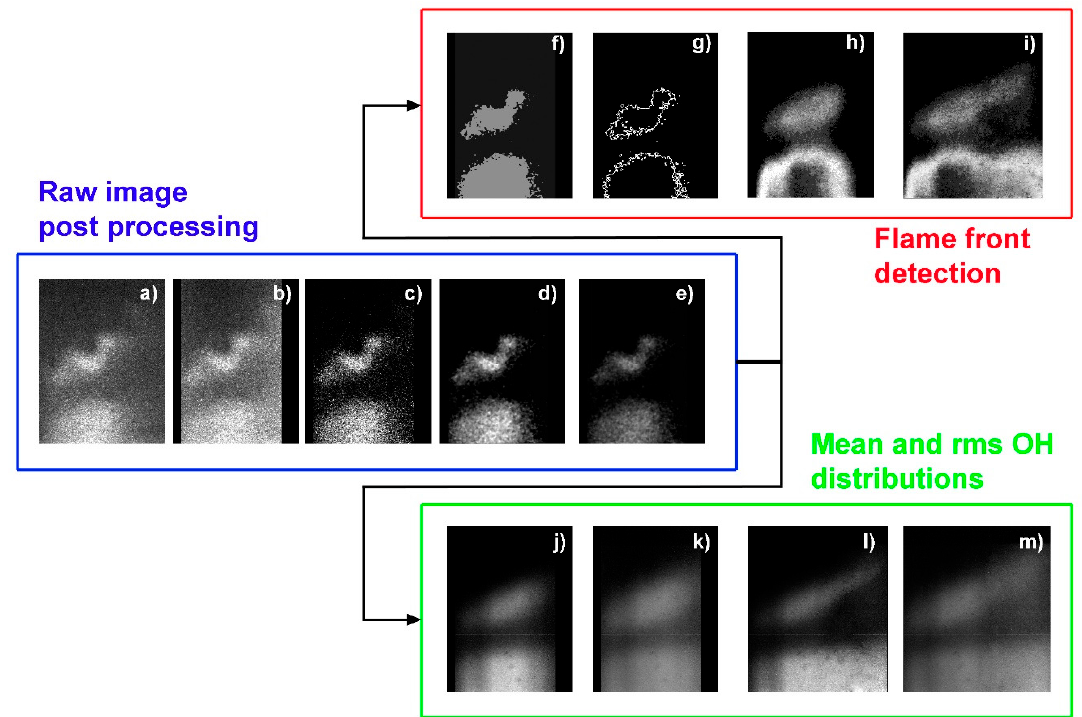
Figure 5. Raw OH-PLIF image processing steps: ( a ) Raw image; ( b ) image balancing and masking; ( c ) background subtraction; ( d ) median (9 × 9) filter application; ( e ) filtering by intensity histogram re-scaling; ( f ) non-linear diffusion (NLD) filter application; ( g ) Sobel gradient detector application; ( h ) averaging of 600 flame fronts; ( i ) joining of the flame front averages from the two LIF investigation areas; ( j ) averaging of 600 OH concentration maps (images from step e); ( k ) RMS (Root Mean Square) of 600 OH concentration maps (images from step e); ( l ) joining of the OH concentration map averages from the two LIF investigation areas; and ( m ) joining of the OH concentration maps RMS from the two LIF investigation areas.